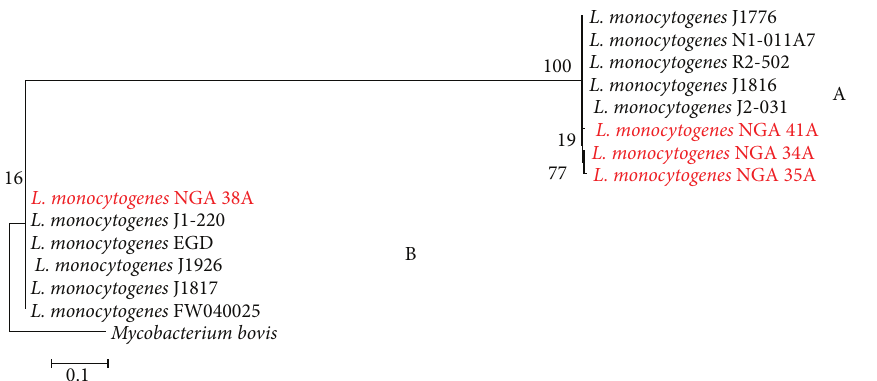
Figure 3: Molecular phylogenetic tree showing relationship between Nigerian L. monocytogenes isolates (red color) with reference sequences from GenBank database. The evolutionary history was inferred by using the Maximum Likelihood method based on the Tamura 3-parameter model. The tree with the highest log likelihood ( − 2760.2483) is shown. The percentage of trees in which the associated taxa clustered together is shown next to the branch and 1000 bootstrap value was used to assess the tree confidence interval. All analyses were performed in MEGA6